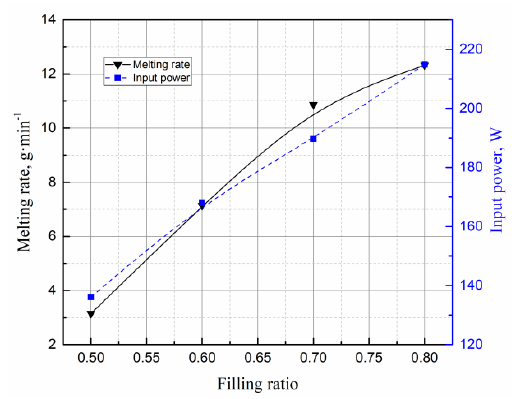
Figure 18. Variation of the melting rate and input power at different filling rates in the physical